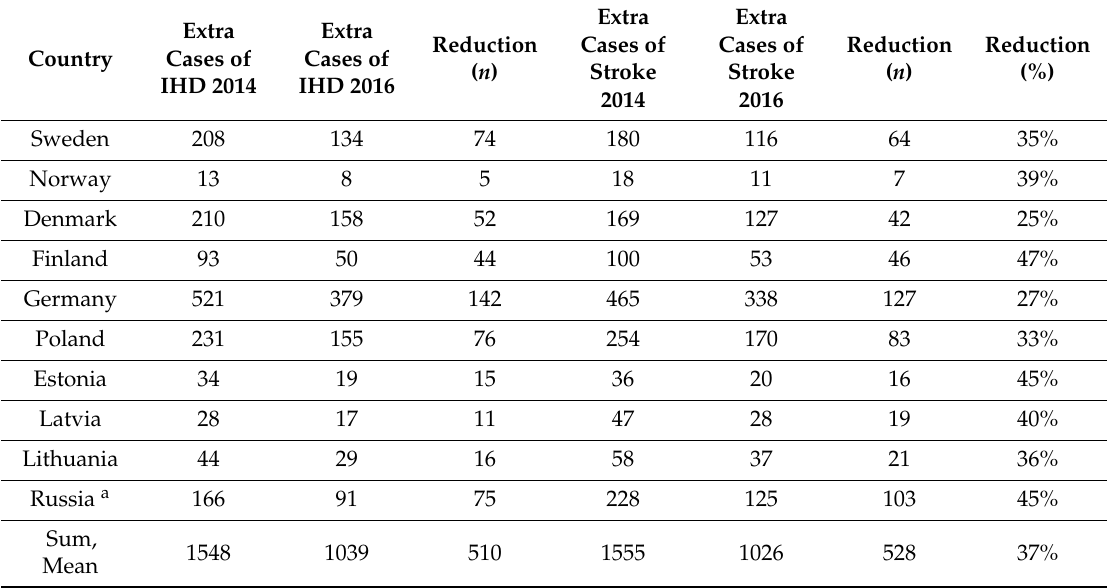
Table 3. Estimated number of extra annual cases of ischemic heart disease and stroke, due to PM 2.5 emissions from Baltic shipping in 2014 and